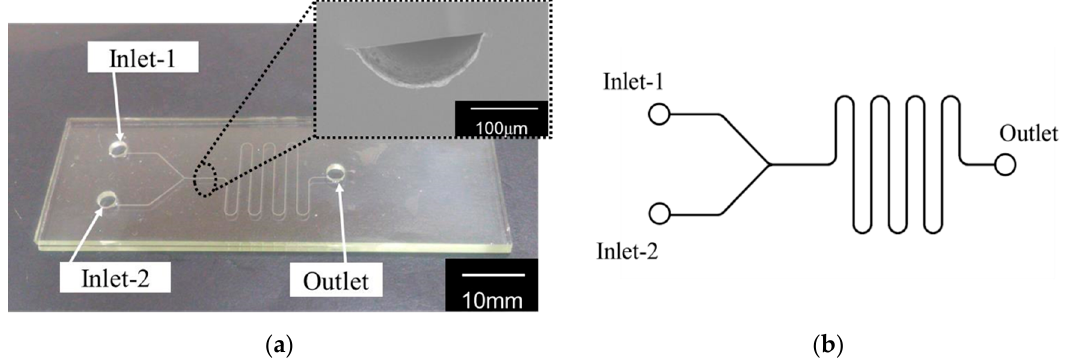
Figure 1. ( a ) Photograph of the fabricated glass microfluidic device with the width of 260 μ m and the depth of 70 μ m; ( b ) The Y shaped microchannel pattern of the device.